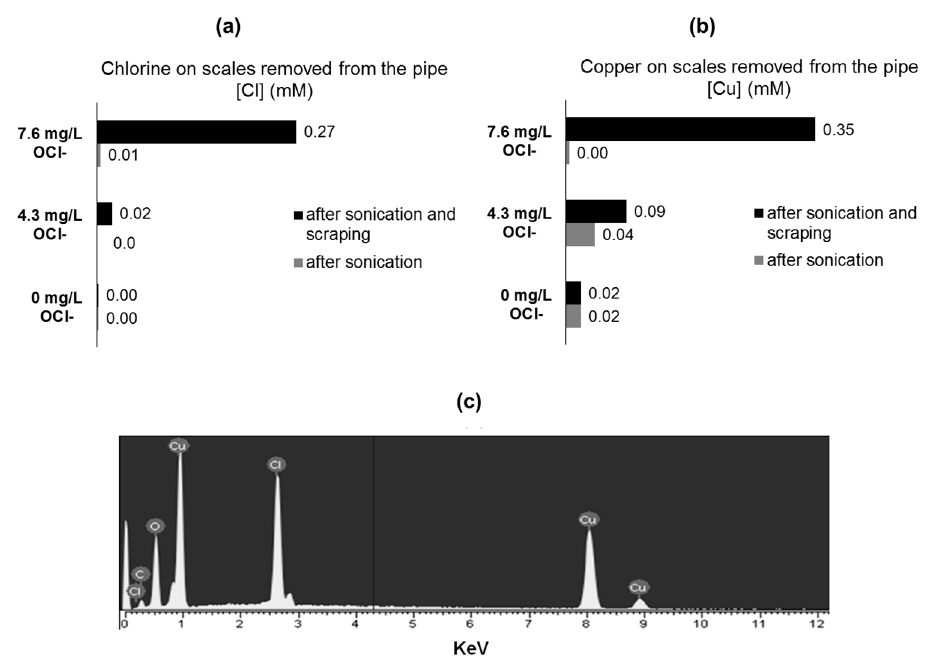
Figure 4. T-XRF measurements of scales removed from the tested copper pipes. Scales removal was done though simple coupon sonication and sonication-scraping ( a ) Chlorine, ( b ) Copper, ( c ) EDS analysis of the corrosion by-products extracted from the inner-surface of a copper stagnated for 8 hours with synthetic water (DIC = 80 mg CaCO 3 /L; OCl - = 8.0 mg Cl 2 /L).